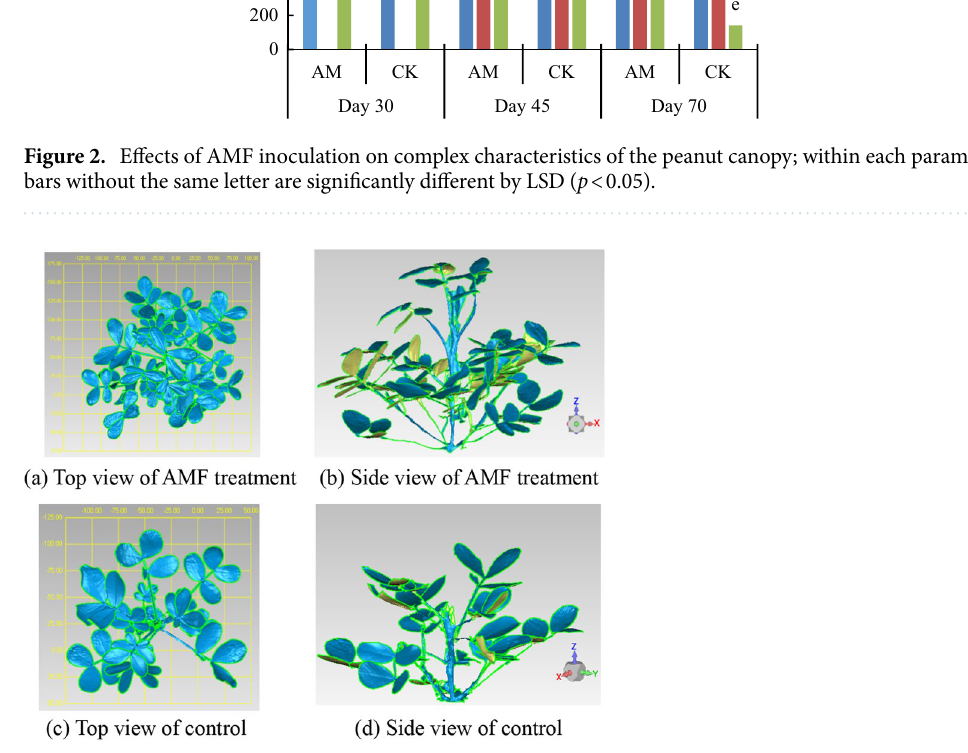
Figure 3. Top view and side view of the peanut canopy in different treatments after 45 days of